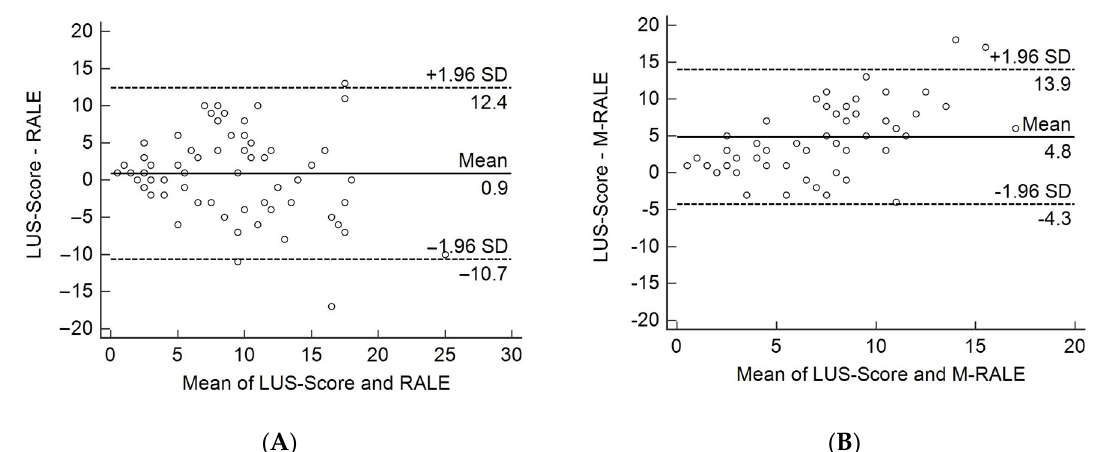
Figure 3. Bland–Altman plots for ( A ) LUS score vs. RALE and ( B ) LUS score vs. M-RALE. Both RALE and M-RALE showed a moderate, significant correlation with LUS score, with only a few outliers in the Bland–Altman plots.